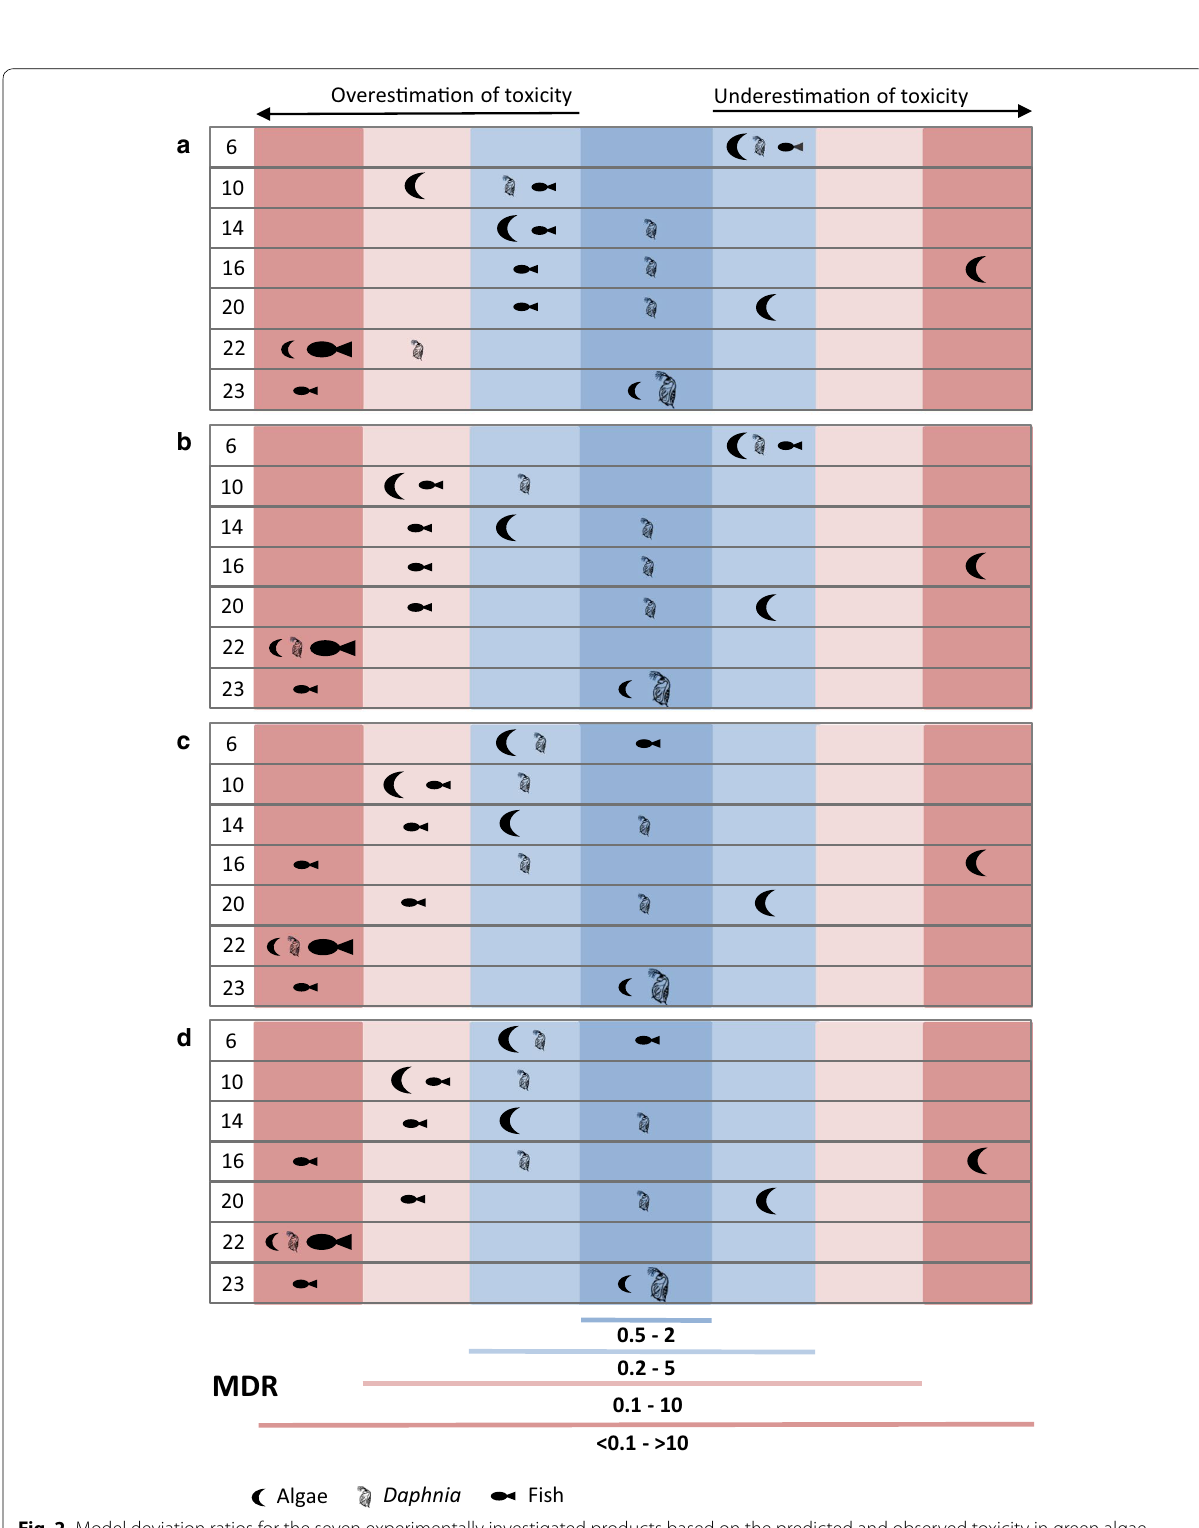
Fig. 2 Model deviation ratios for the seven experimentally investigated products based on the predicted and observed toxicity in green algae (ErC 50 ), Daphnia magna (EC 50 ), and fish embryos (LC 50 ). Symbols for the most sensitive end point for each product are enlarged. a Based only on the a.s. using measured concentrations in the test solutions; b based only on the a.s., assuming maximum allowed concentrations in the products; c based on the a.s. and all additives categorized as ‘HAZ’ or ‘CLP’, assuming maximum allowed concentrations in the products; d based on the a.s. and all additives for which at least one end point of aquatic toxicity was available, assuming maximum allowed concentrations in the